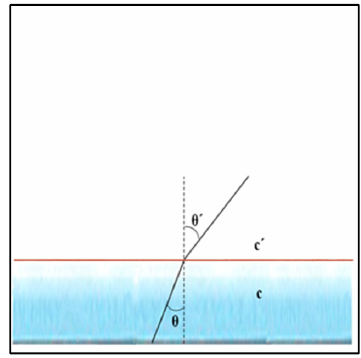
Figure 3. Refraction—sound physical phenomenon.